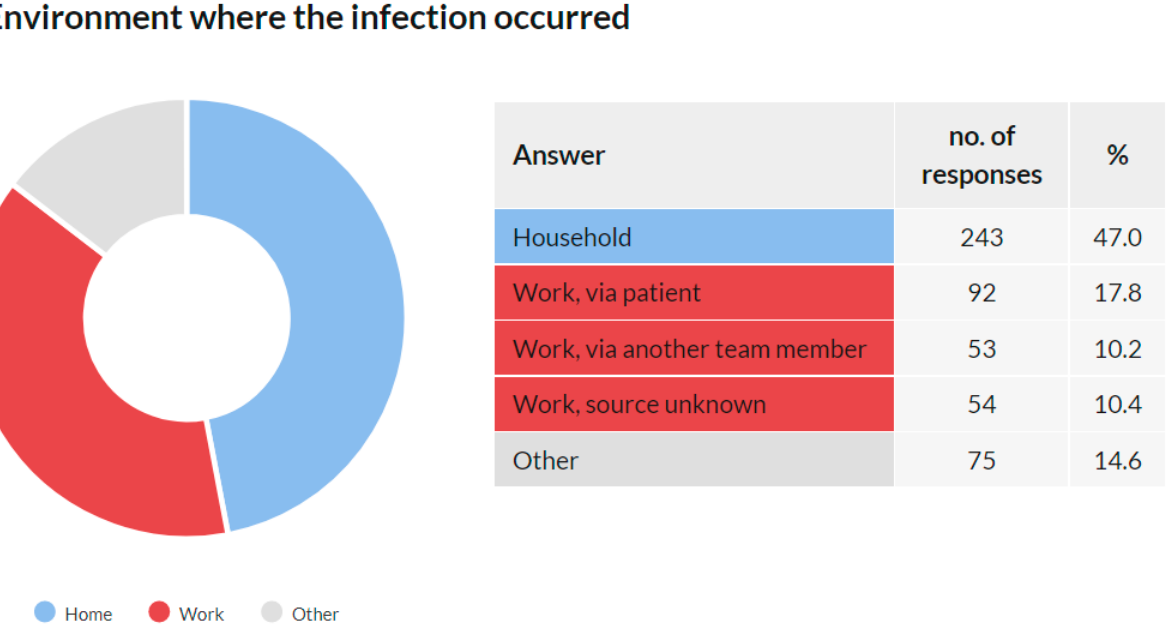
Figure 12. The environment where the infection occurred.